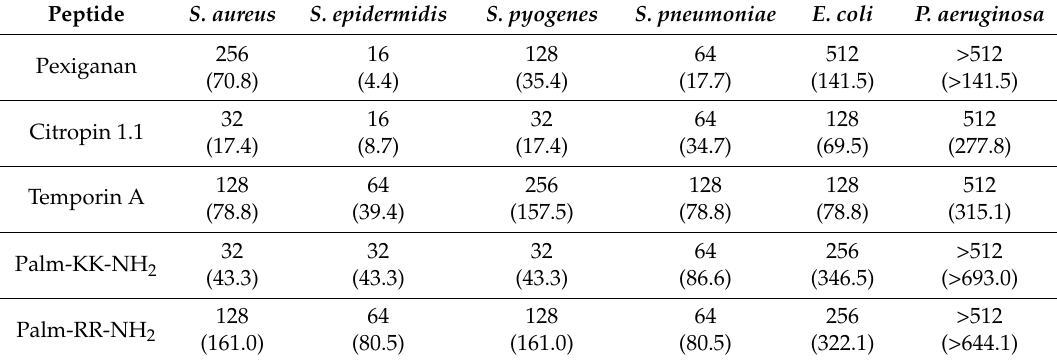
Table 3. Minimum biofilm eradication concentration (reduction of resazurin ≤ 10% ± 0.5%) at 25 ◦ C ( µ g/mL ( µ M)).